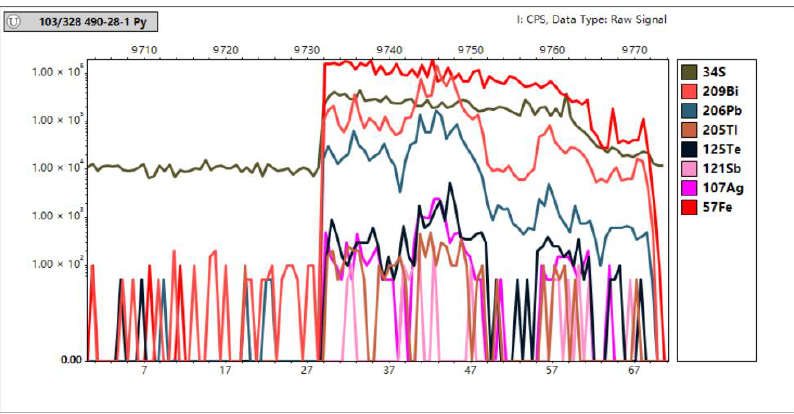
Figure 7. Time-resolved depth profiles of Bi, Pb, Tl, Te, and Ag in Sample 490-28.